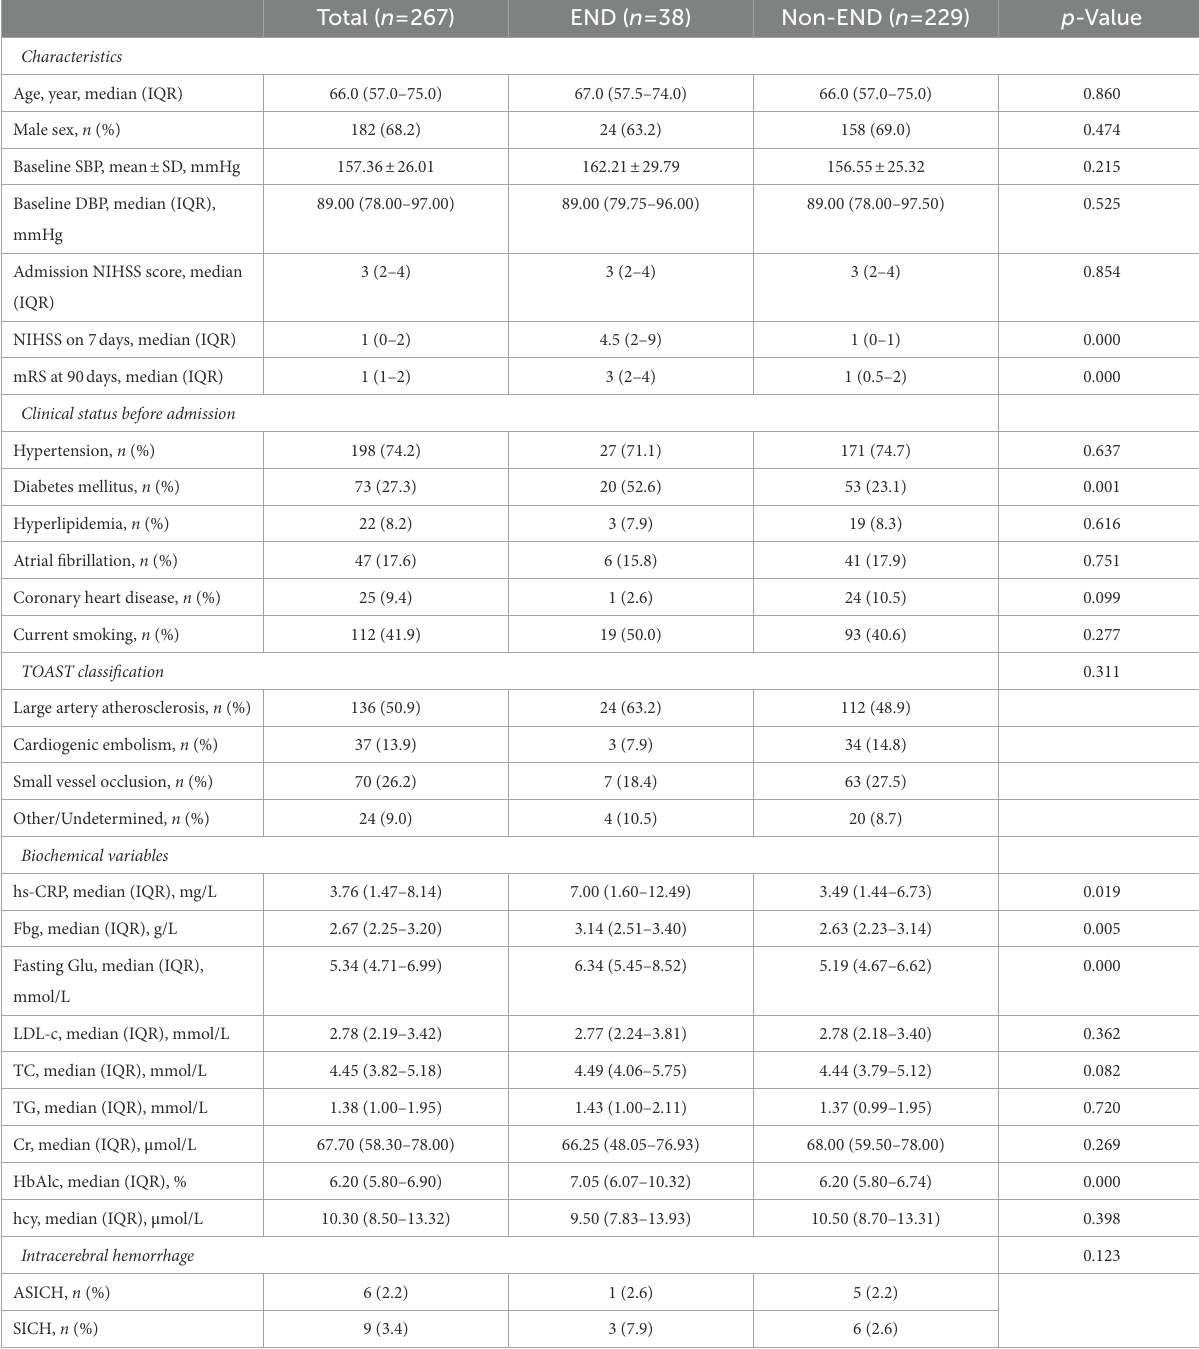
TABLE 1 Baseline clinical and biochemical characteristics, according to END.